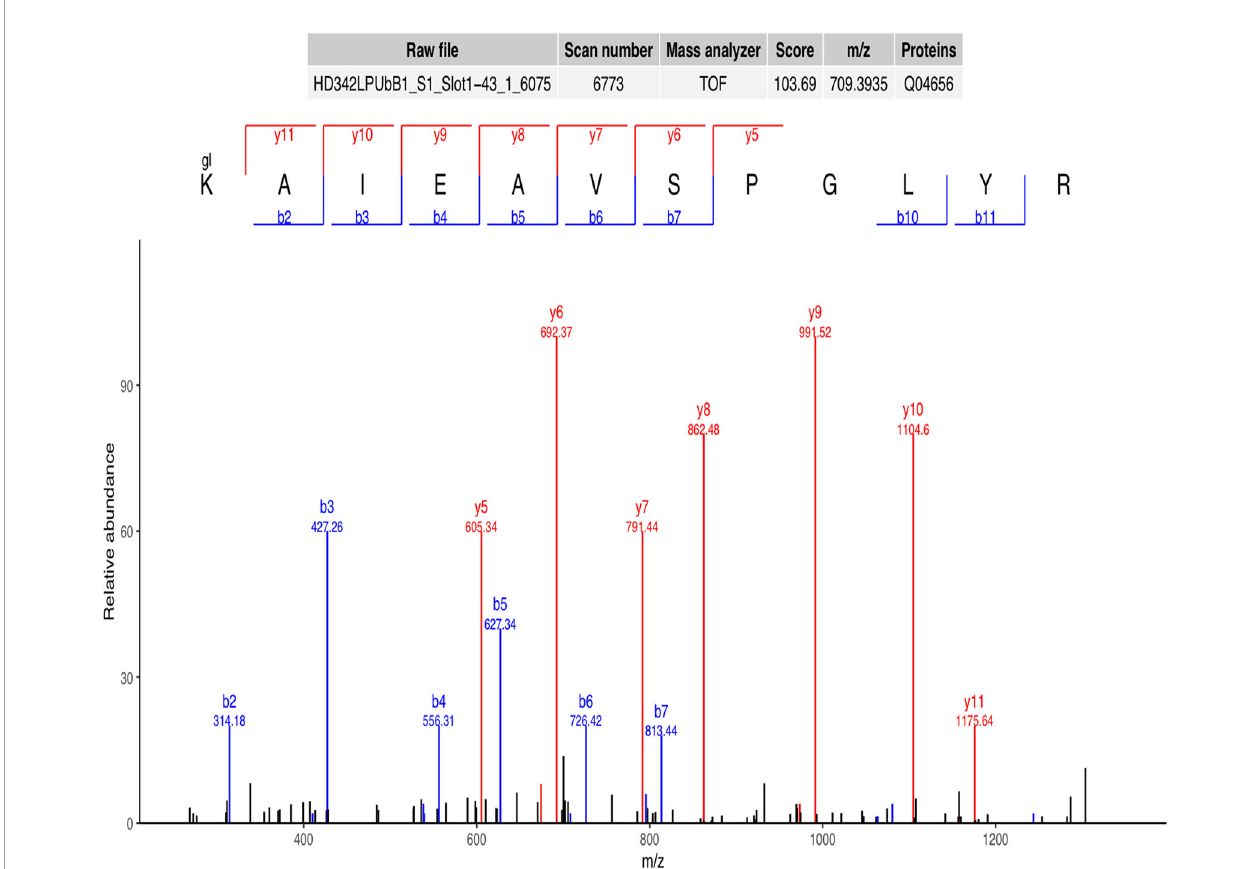
FIGURE 2 | Representative ubiquitinated peptide spectrum: 333 K*AIEAVSPGLYR 344 (m/z=709.39) from ATP7A (Protein Session: Q04656), K* = ubiquitinated lysine